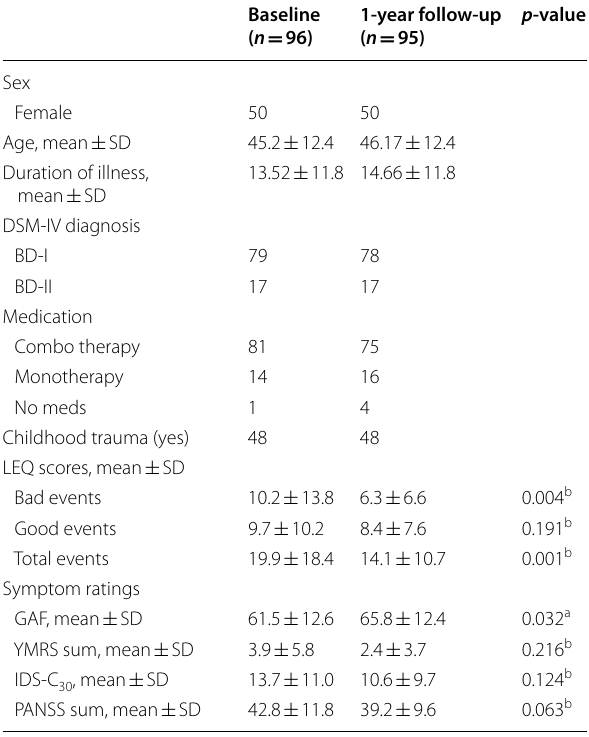
Table 1 Sample demographic and clinical